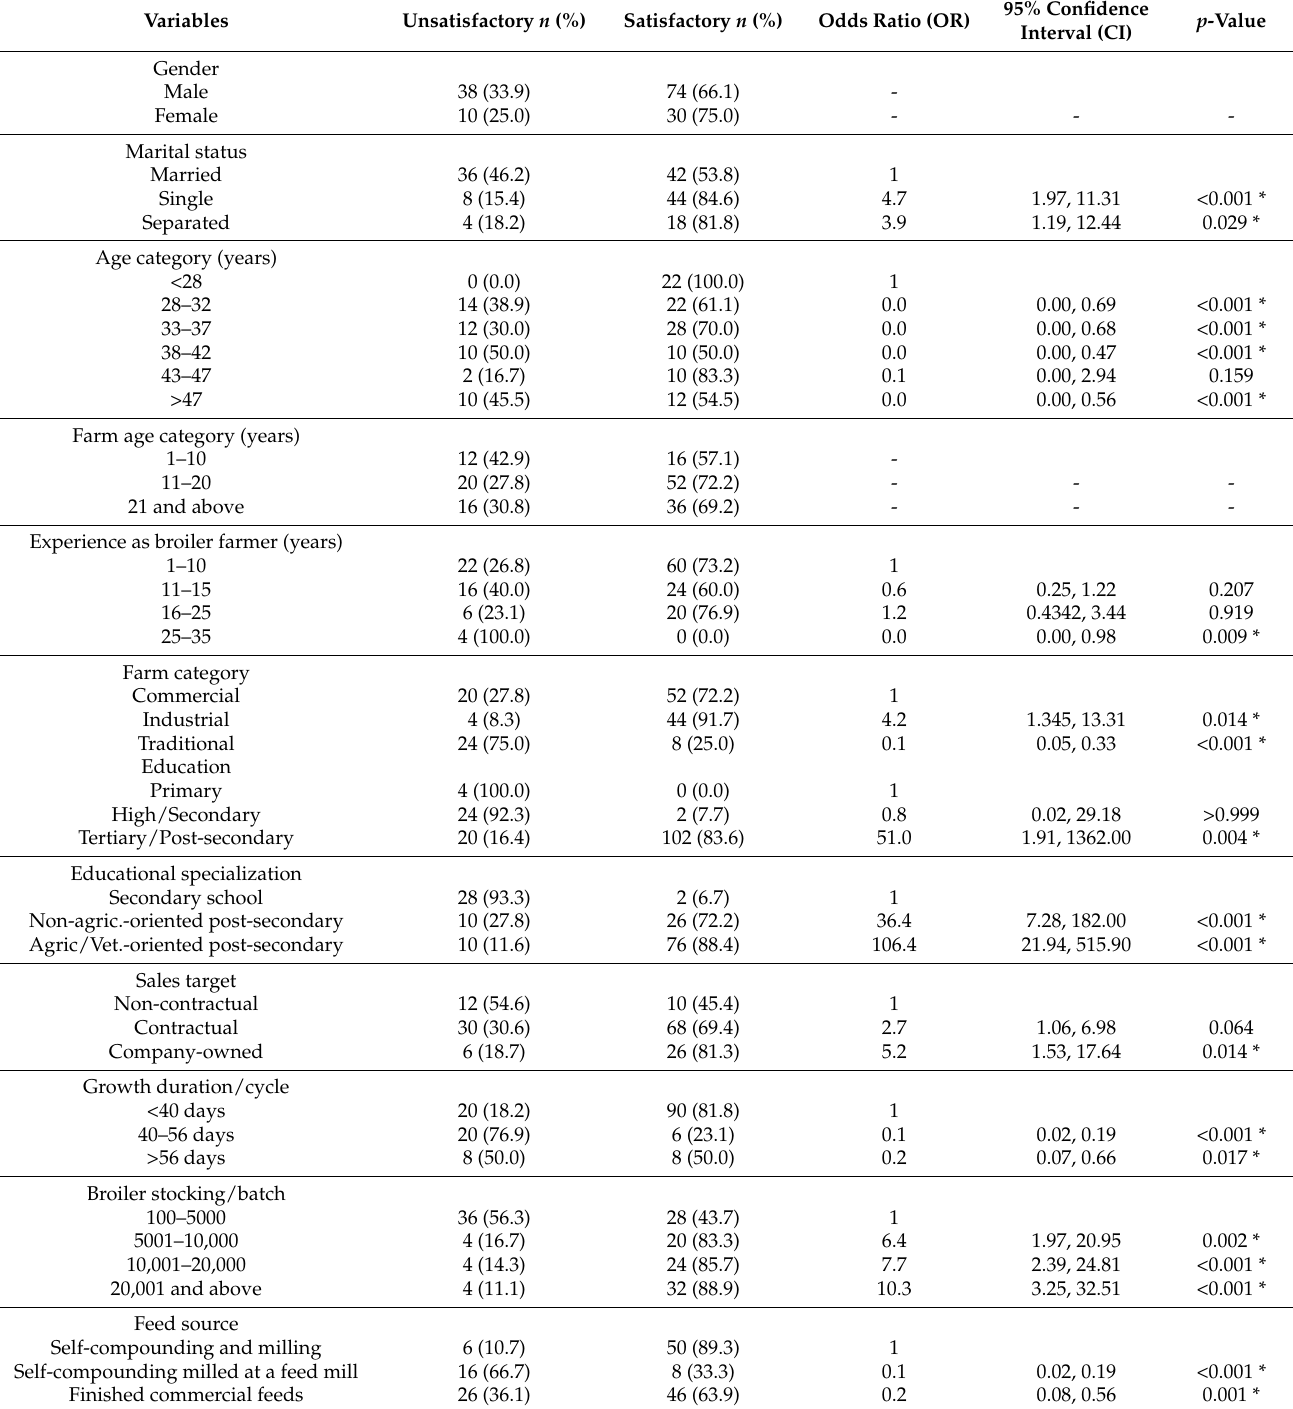
Table 8. Factors affecting attitudes to practices of antimicrobial use and resistance among broiler grow-out farmers in Oyo State,